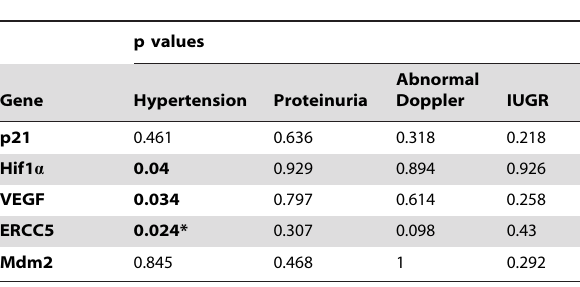
Table 3. Association between hypertension, proteinuria, abnormal fetoplacental Doppler and IUGR with the expressions of the different genes in the maternal